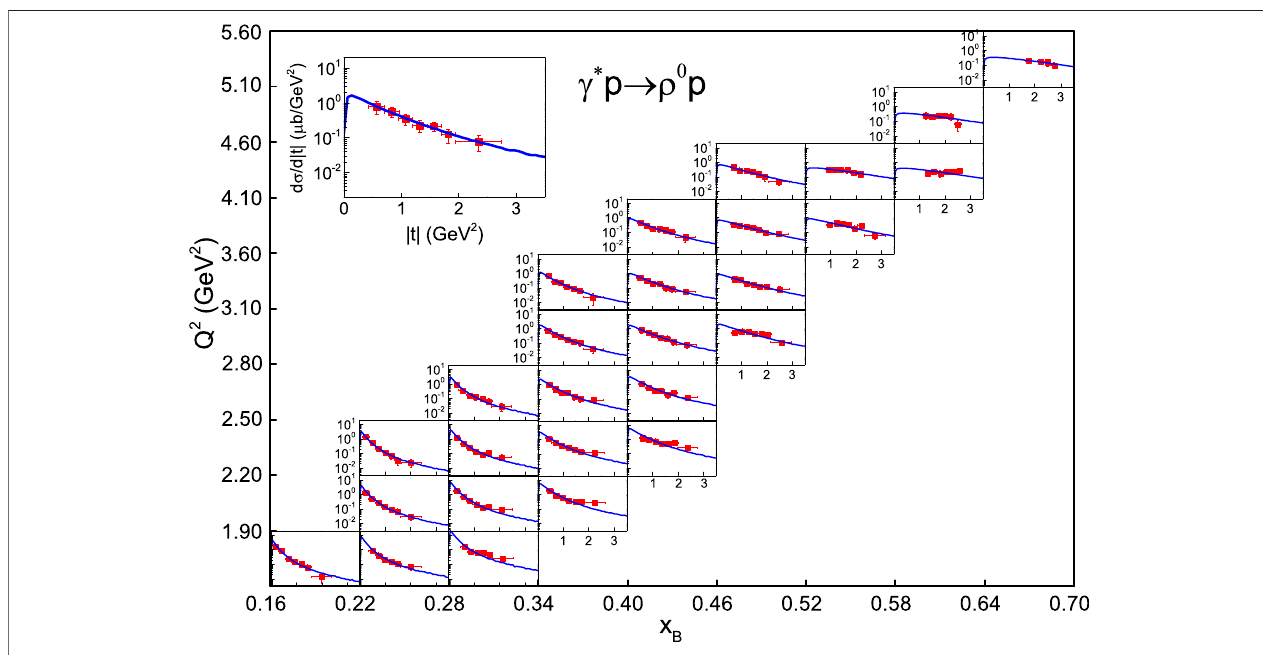
FIGURE 4 | The differential cross-section d σ / d | t | in | t | of c * p → ρ 0 p process produced in ep collisions at beam energy of 5.754 GeV in different Q 2 and x B ranges showninthepanels.Asanexample,thesampleatthetop-leftsub-panelshowsrepeatedlytheresultin2.8 < Q 2 < 3.1 GeV 2 and0.40 < x B < 0.46.Thesymbolsrepresent the experimental data measured by the CLAS Collaboration [40] and the curves are the statistical results obtained as those in Figure 1 .